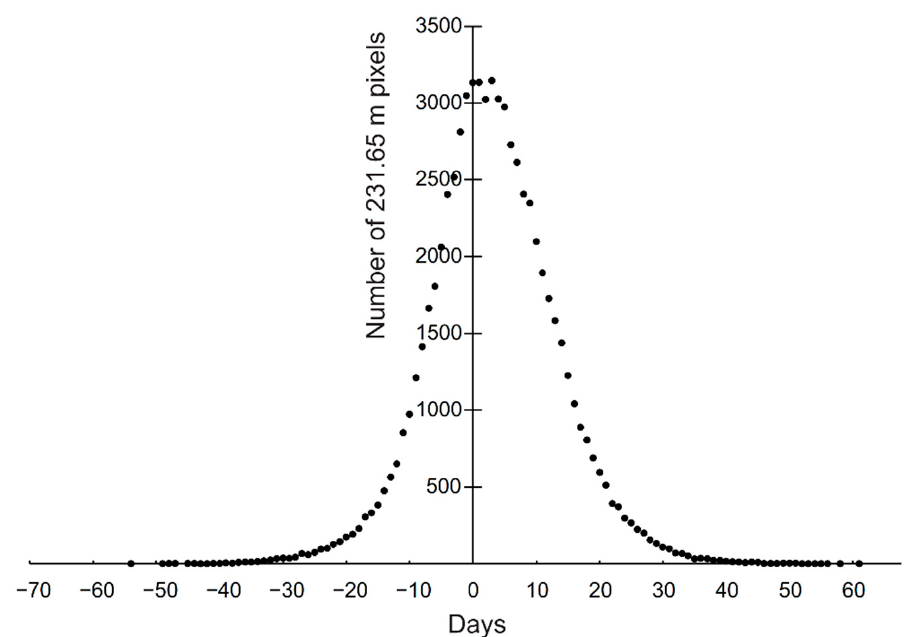
Figure 2. Comparison between Sentinel-2- and MODIS-based mapped day of onset of vegetation growth in 2019 in central Svalbard. The figure shows number of pixels and number of days differences between the Sentinel-2-based and the MODIS-based day of onset of growth after the Sentinel-2 pixels were resampled to MODIS pixel size.